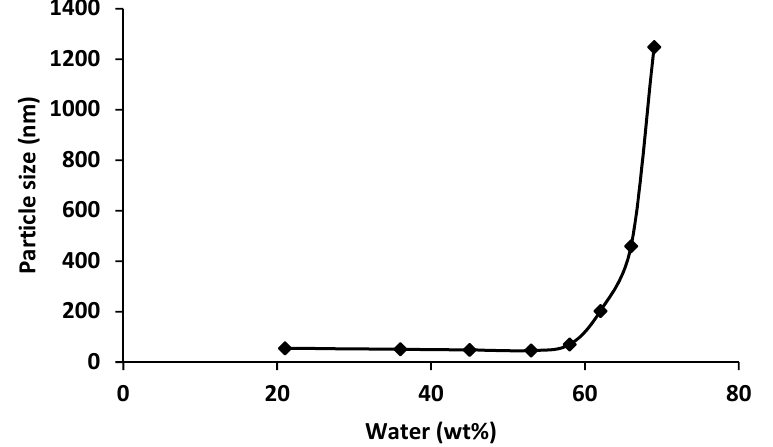
Figure 2. Particle size (nm) of PMMA- b -PSBMA block copolymer solution in 2,2,2-trifluoroethanol / water medium vs. water concentration.